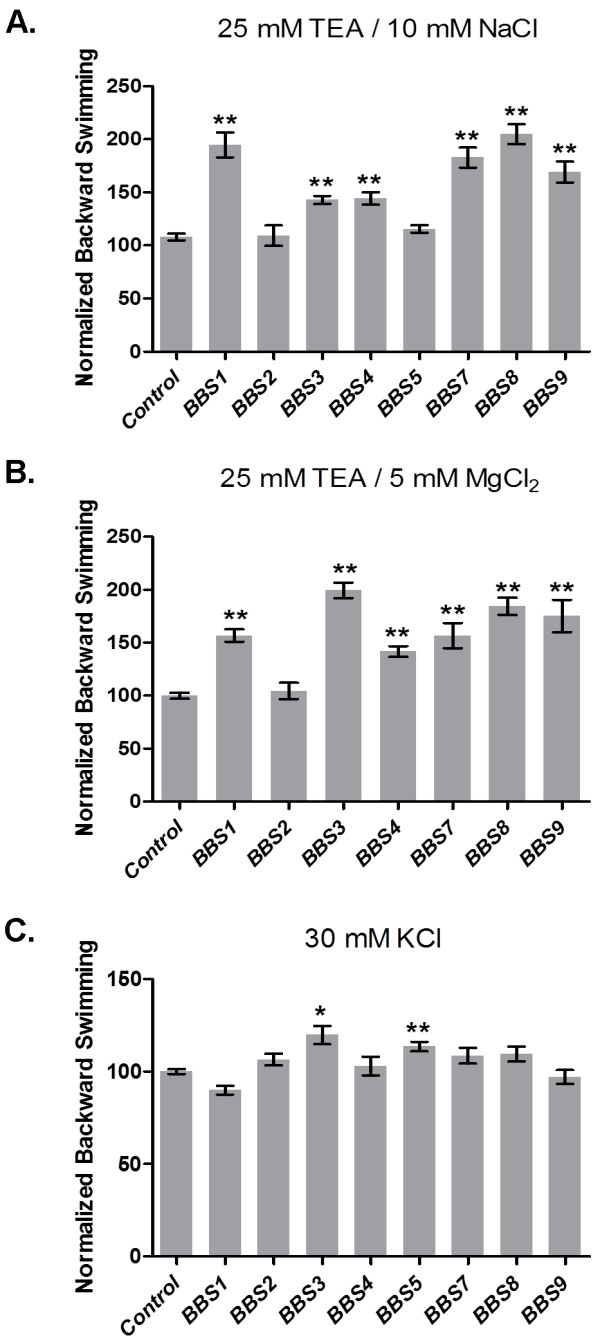
Backward swimming duration after depolarization in tetraethylammonium chloride (TEA) with Na+, TEA with Mg2+, or KCl. Durations of backward swimming (sec) in buffers with: (A) 25 mM TEA with 10 mM NaCl, (B) 25 mM TEA with 5 mM MgCl2; and (C) 30 mM KCl. Data are normalized to the control backward swimming duration. Asterisks denote significant difference from control using the Mann–Whitney U-test (*P < 0.05; **P < 0.0001). Data are averages from three experiments; n = 45 to 418 (A); 45 to 165 cells (B) and 25 to 240 (C). Data are averages ± standard error of the mean (SEM).